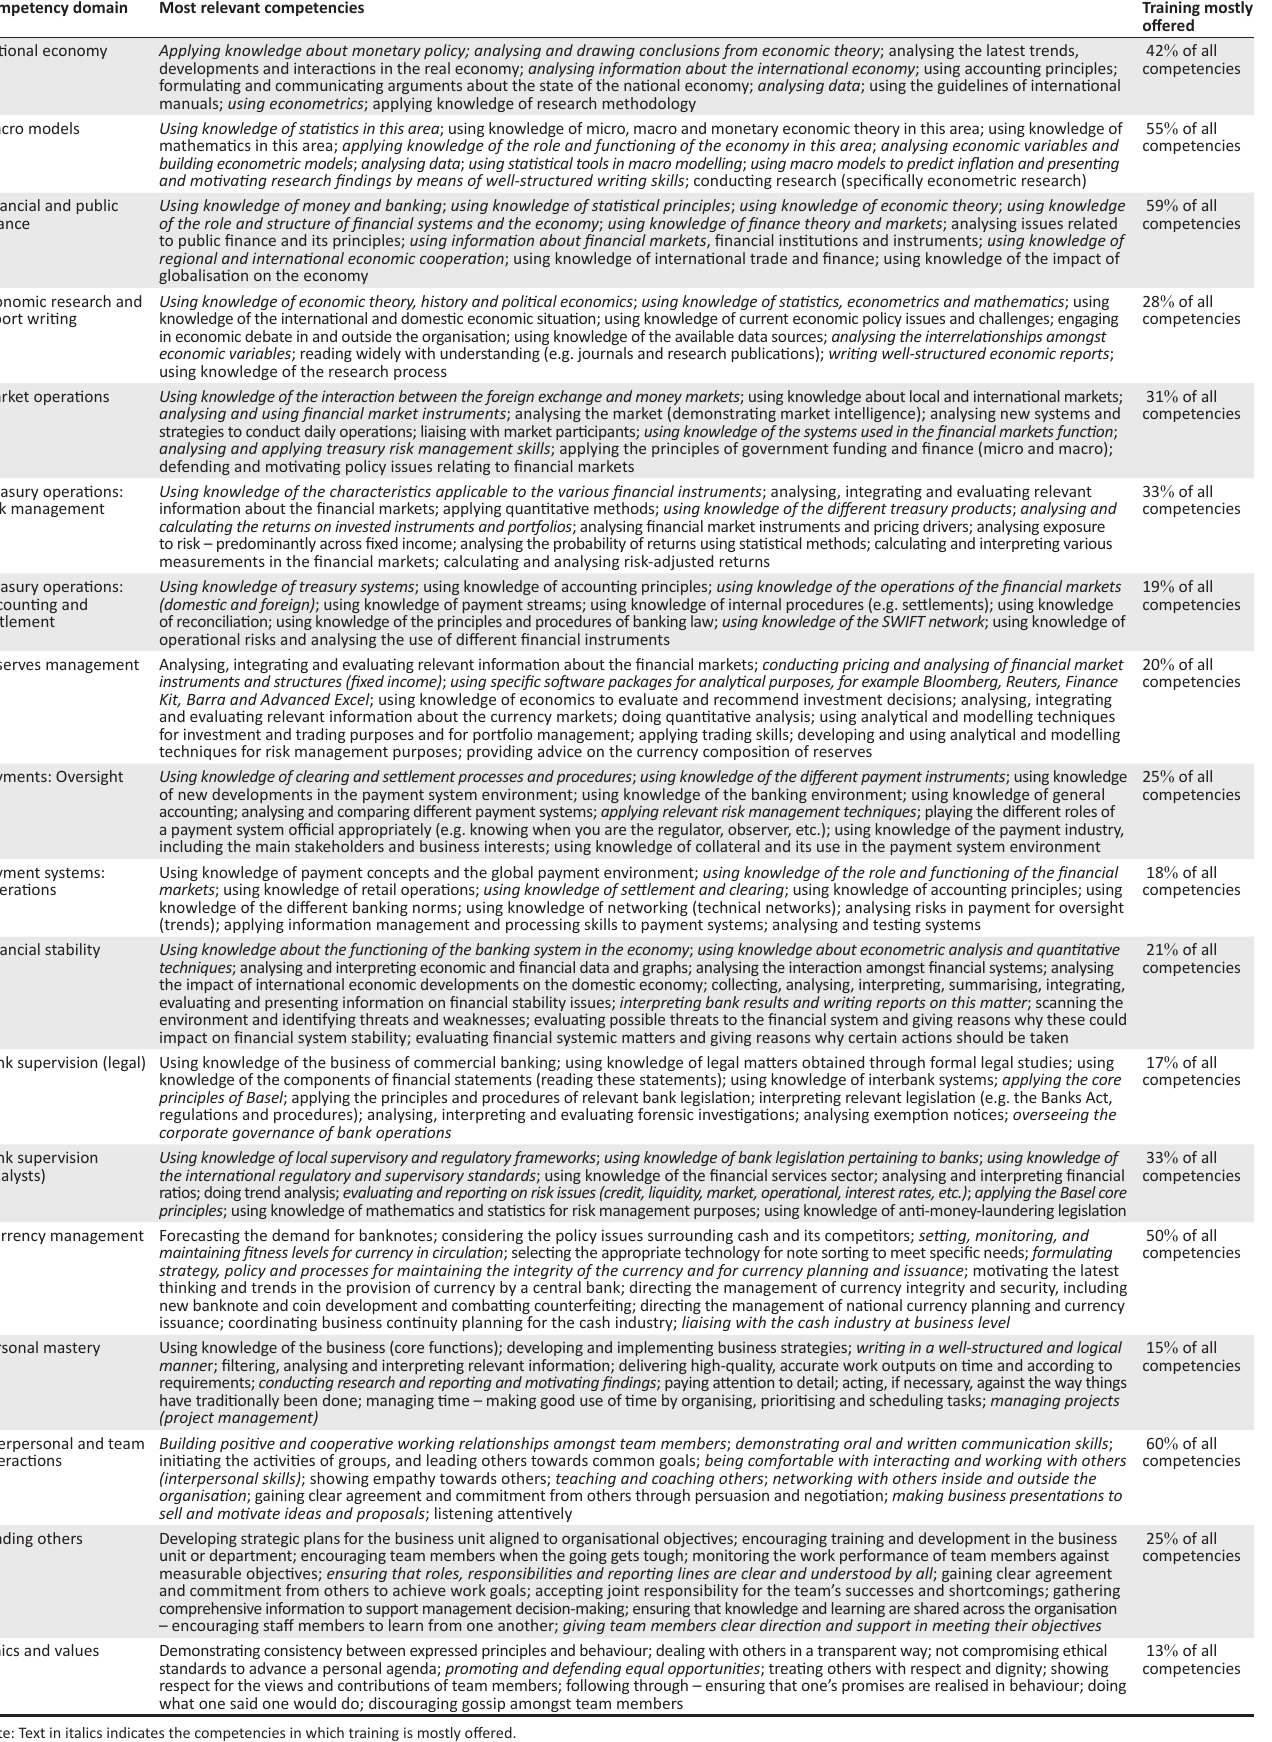
TABLE 5: Quantitatively validated global central banker competency model: Top ten most relevant competencies and training mostly offered. Competency domain Most relevant